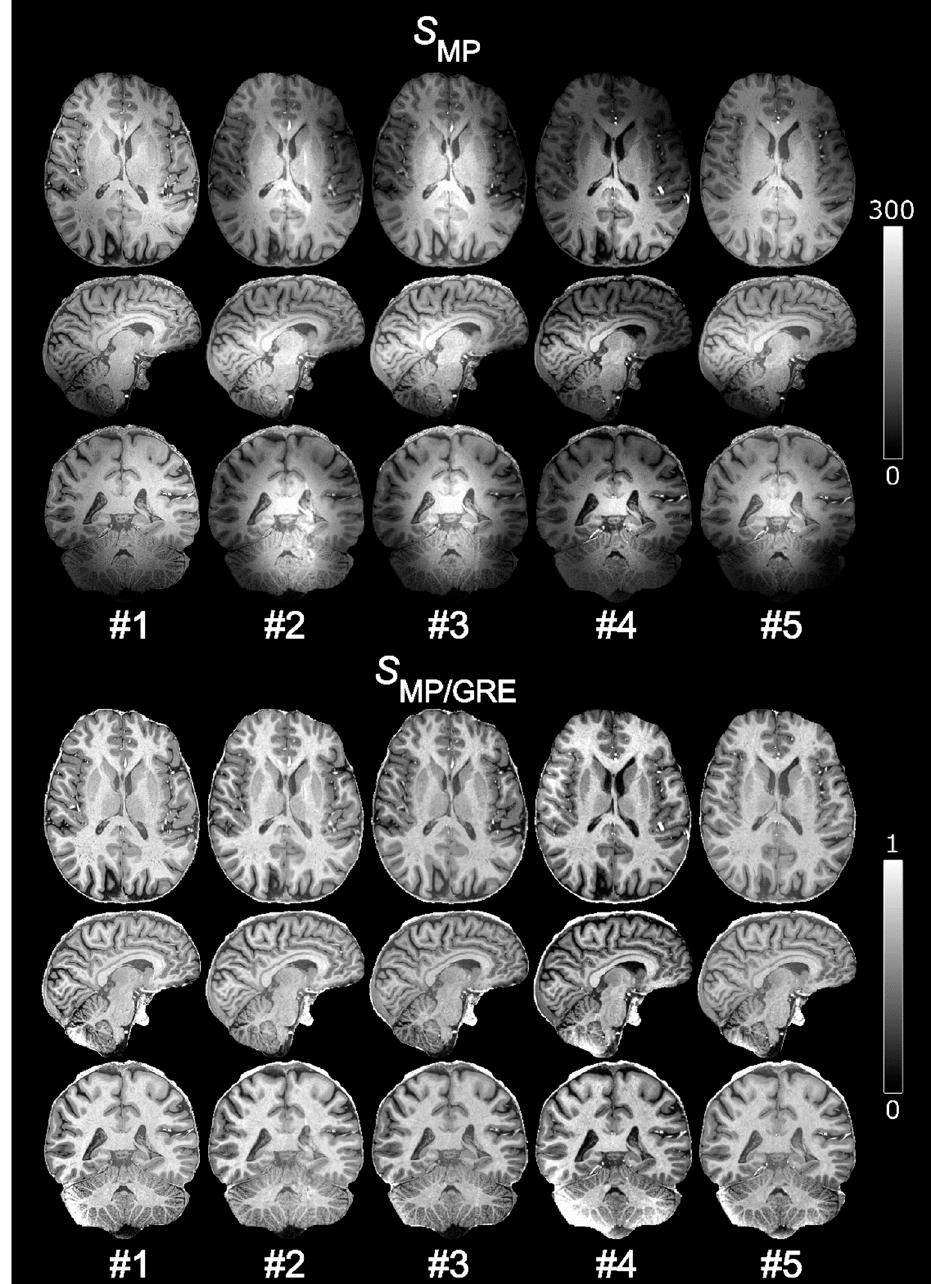
Figure 4. MPRAGE volumes before ( S MP ) and after ( S MP/GRE ) normalization, acquired on a subject scanned at five separate sessions (day 1, 161, 170, 189, and 253). Influence from the bias field is noticeably reduced after normalization. Hyperintense pixels indicate a failed adiabatic inversion. At the 4th scanning session, there was possibly a transmitter adjustment failure, resulting in generally lower B 1+ and thus a generally darker S MP image as well as a larger area of very bright pixels in the cerebellumum of S MP/GRE